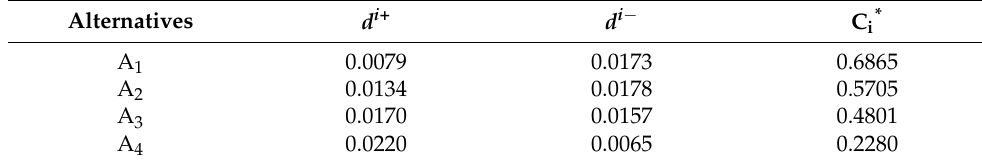
Table 9. Closeness coefficients of the alternatives.